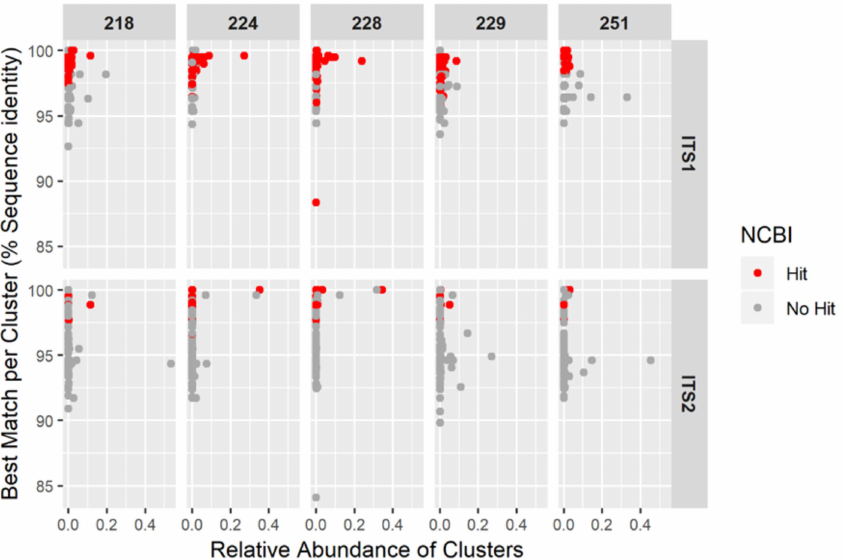
Figure 5. Result of searching the sequence clusters against the NCBI database with reference to results which are a ‘hit’ for Hypericum (red dots) and those that are not (grey dots). Each data point represents a sequence cluster and the colour denotes whether a cluster was assigned to genus Hypericum .